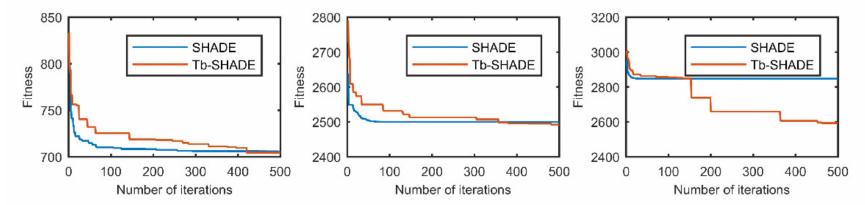
Figure 1. The selected average convergence of SHADE and Tb-SHADE on CEC2020 in 5 D is compared. From left to right f3, f9 and f10.